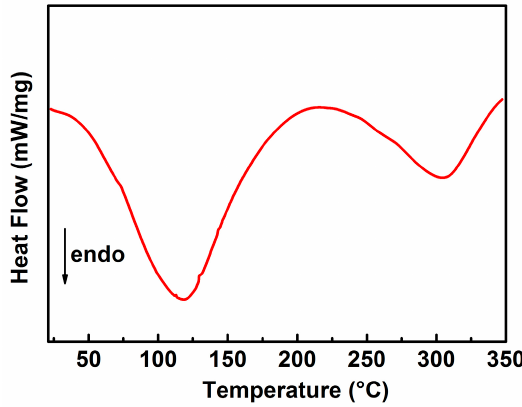
Figure 6. DSC curve of PAN-based gel polymer electrolyte.